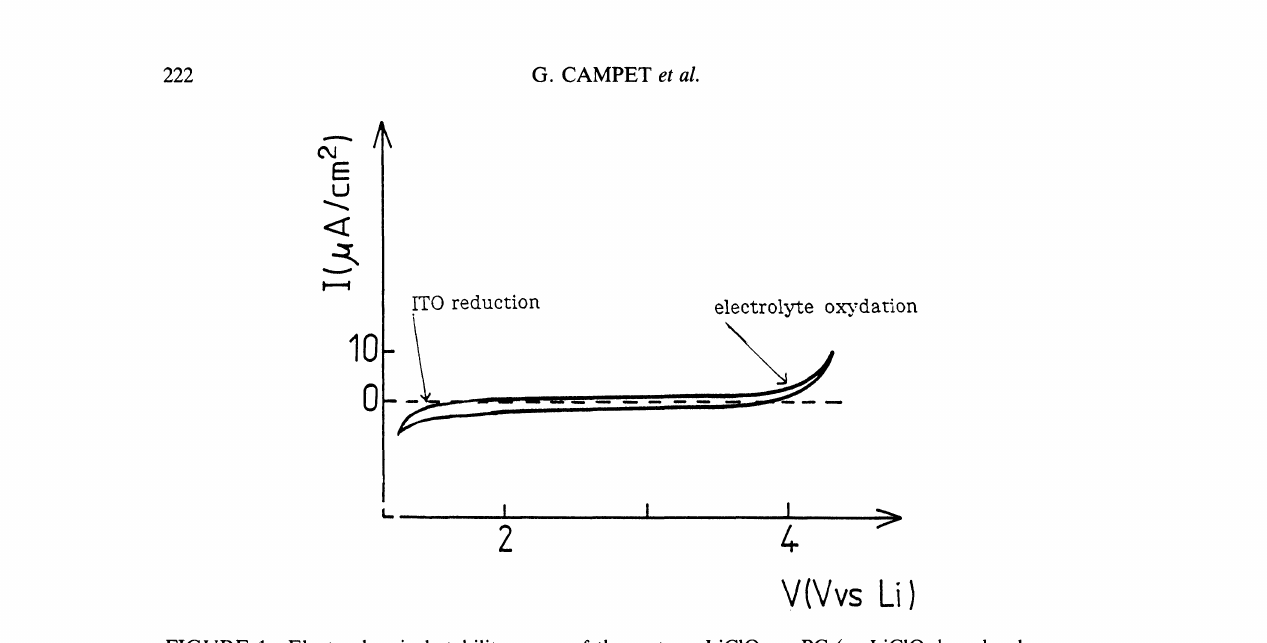
FIGURE Electrochemical stability range of the system: LiCIO4 PC (or LiCIO4-based polyure- thane) electrolyte/ITO (30 O/M) coated float-glass.